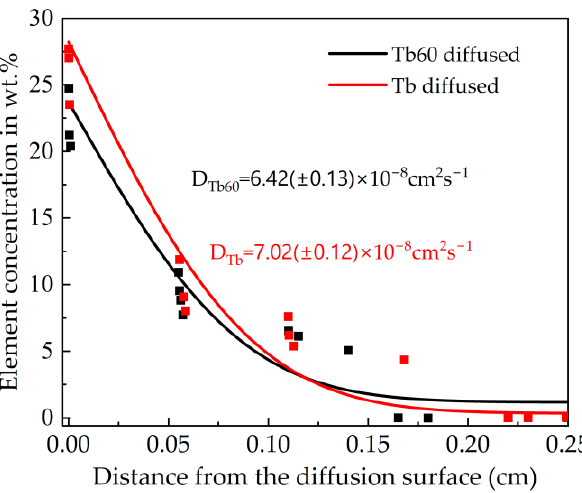
Figure 5. Tb concentrations at different depths and the corresponding fitting curves of Tb60 diffusion magnet and Tb diffusion magnet.